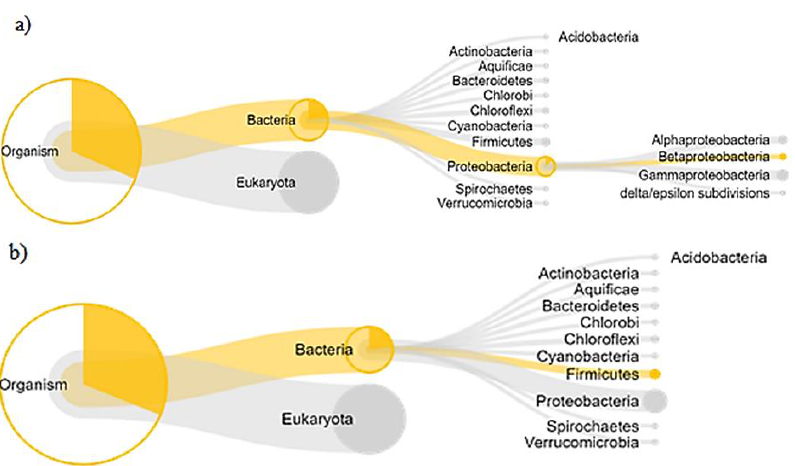
Figure 7. Unipept treeview examples of detected biological processes that can confirm ecological attributes of some bacteria taxa. The highlighted part shows detected peptides related to a specific biological process. ( a ) Lipopolysaccharide transport (GO: 0015920) and “ response to organic substances” (GO: 0010033) detected in Betaproteobacteria in R4 soil; ( b ) “spore biosynthesis” (GO: 0030435) detected in Firmicutes in R4 soil.